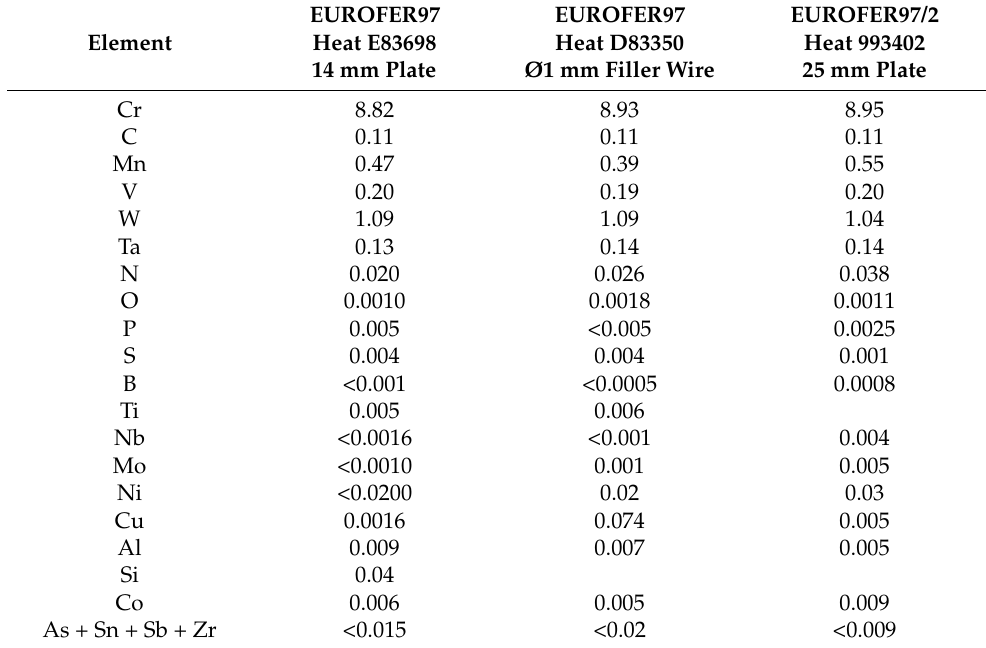
Table 1. Chemical composition of different EUROFER heats. Values are given in weight % by the manufacturer [26,27]. Note: Ti and Si were not analyzed for all